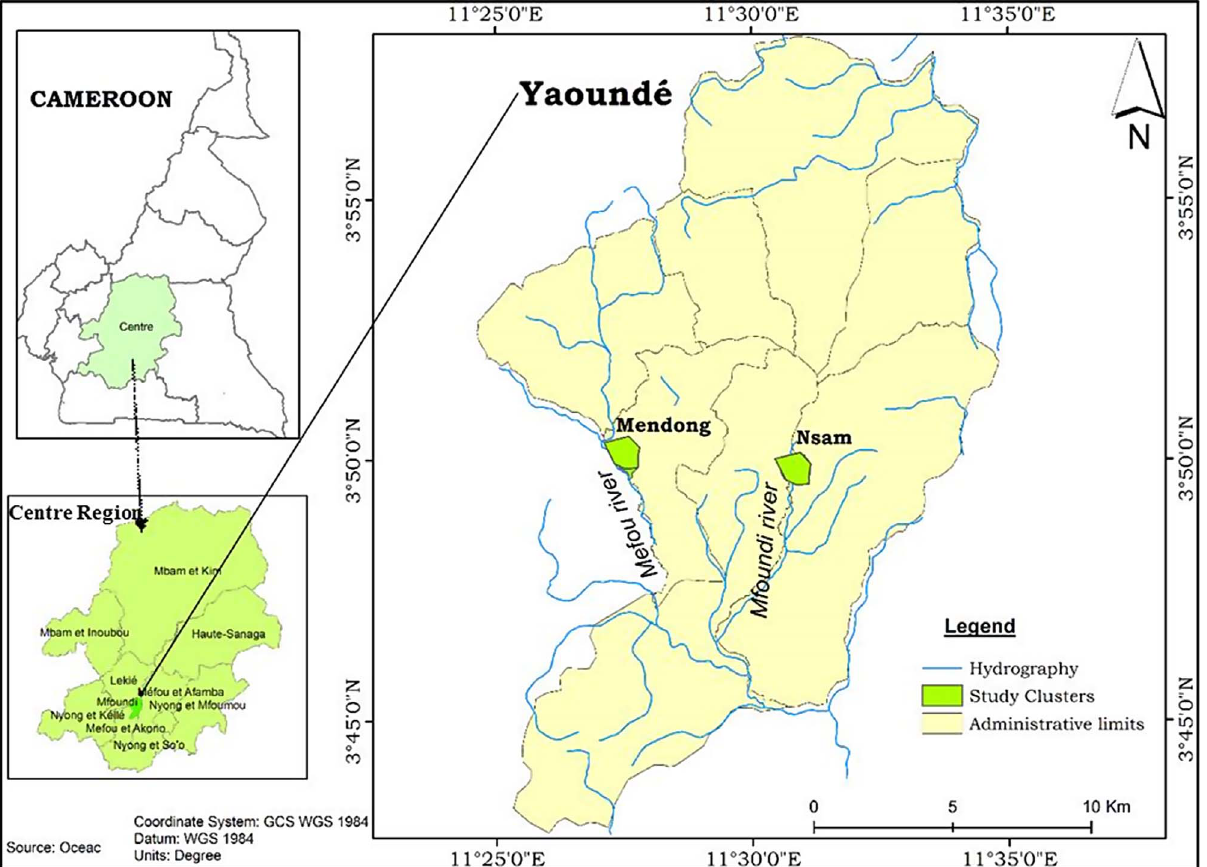
Figure 1. A map of Yaoundé showing the study sites of Mendong and Nsam.